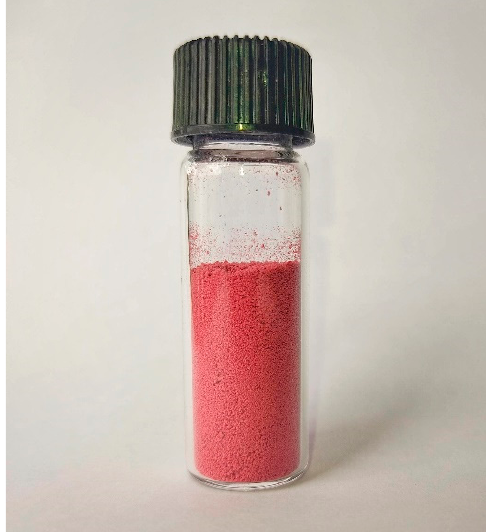
Figure 7. Photograph of H. macrocarpa and nanocellulose powder.